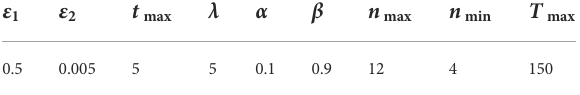
TABLE 1 Main parameters of LALO.